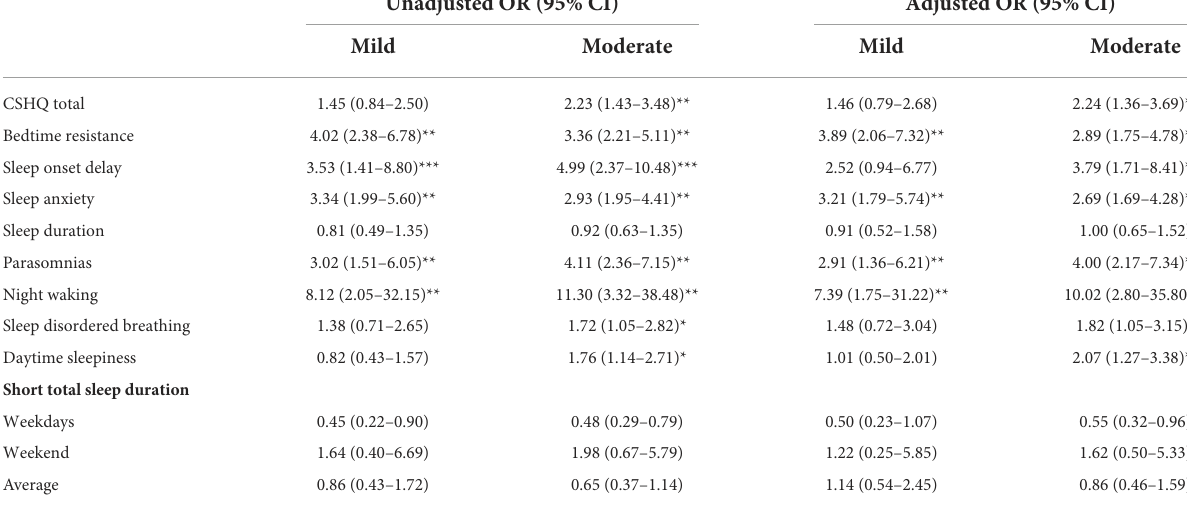
TABLE 5 Association of TD severity with sleep disturbances and short sleep.